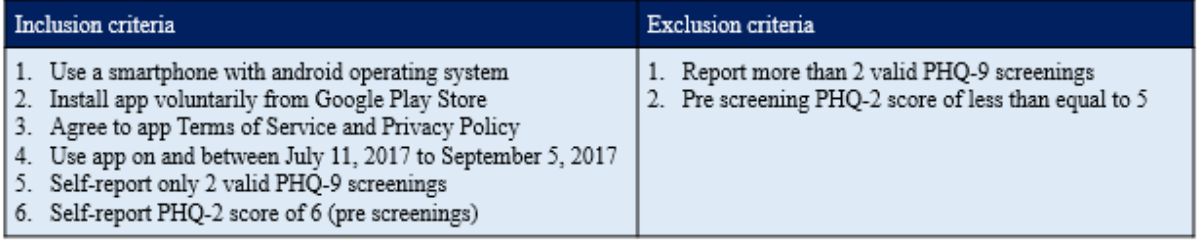
Figure 1. The study inclusion criteria. PHQ: Patient Health